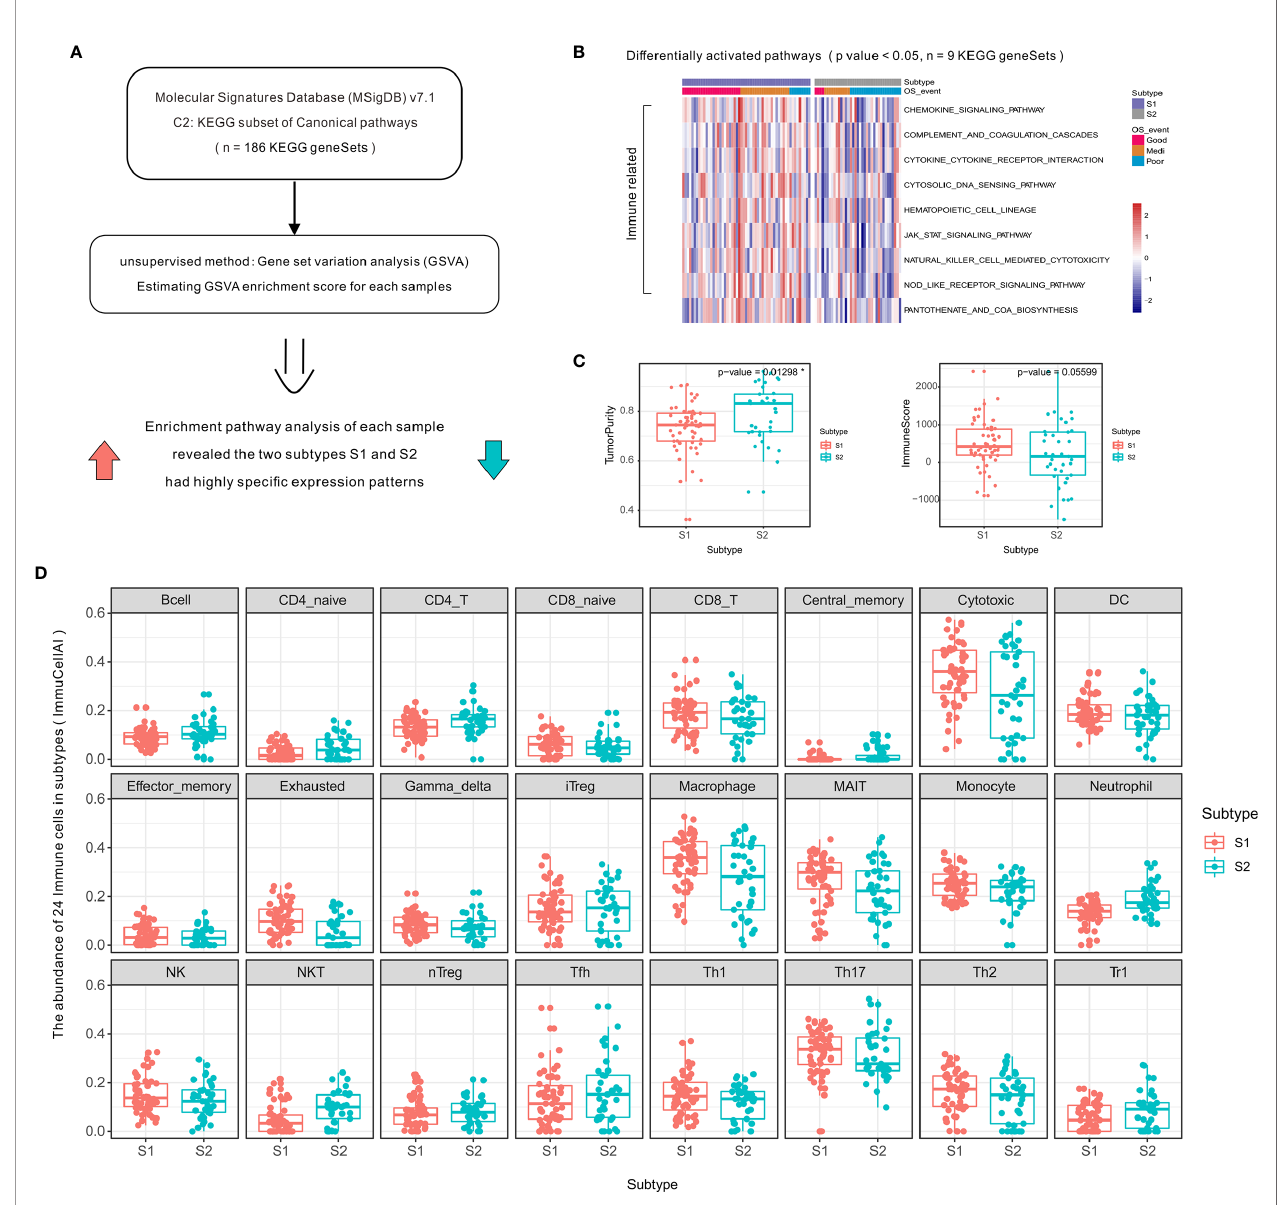
FIGURE 2 | Activation level of speci fi c immune-related pathways and increased immune cell in fi ltration in OSA TME subtype S1 compared to that of subtype S2. (A) Schematic diagram of enrichment analysis of signaling pathways. (B) Heatmap showing enrichment scores of signi fi cantly different KEGG gene sets. (C) Tumor purity and ImmuneScore for each subtype generated using the ESTIMATE algorithm. (D) Immune cell in fi ltration differences between OSA TME subtypes using ImmuCellAI. *mean p-values <